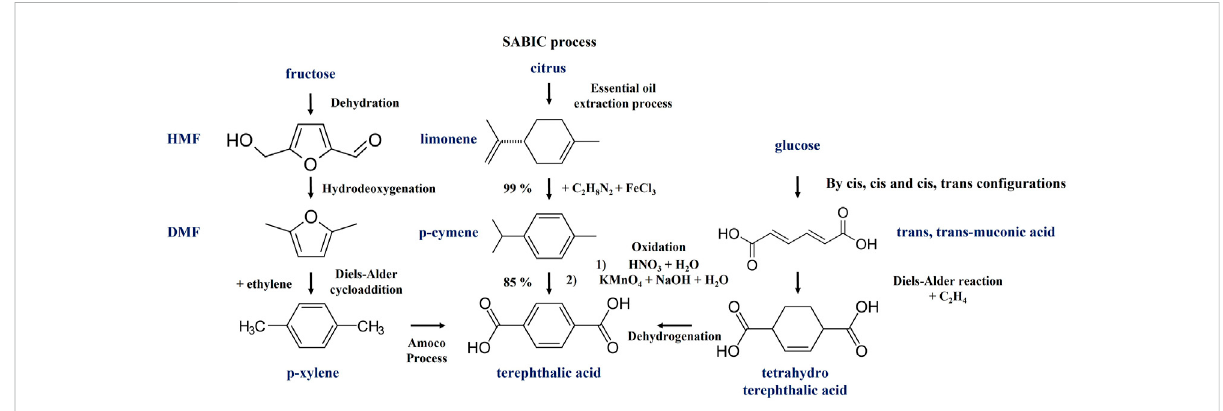
FIGURE 4 Conversion pathway for terephthalic acid from HMF, limonene and muconic acid.